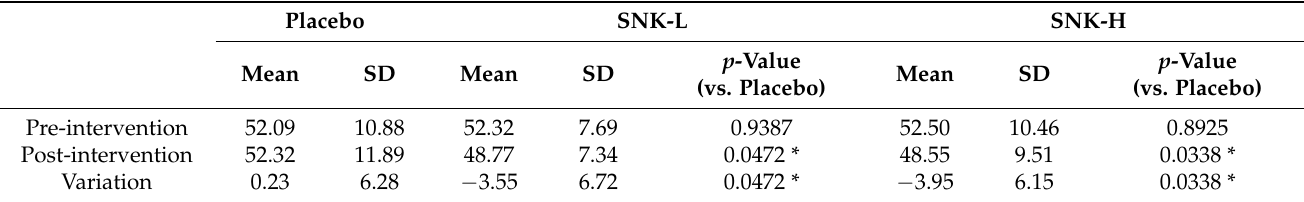
Table 4. TMD scores after stress loading (pre- and post-intervention).